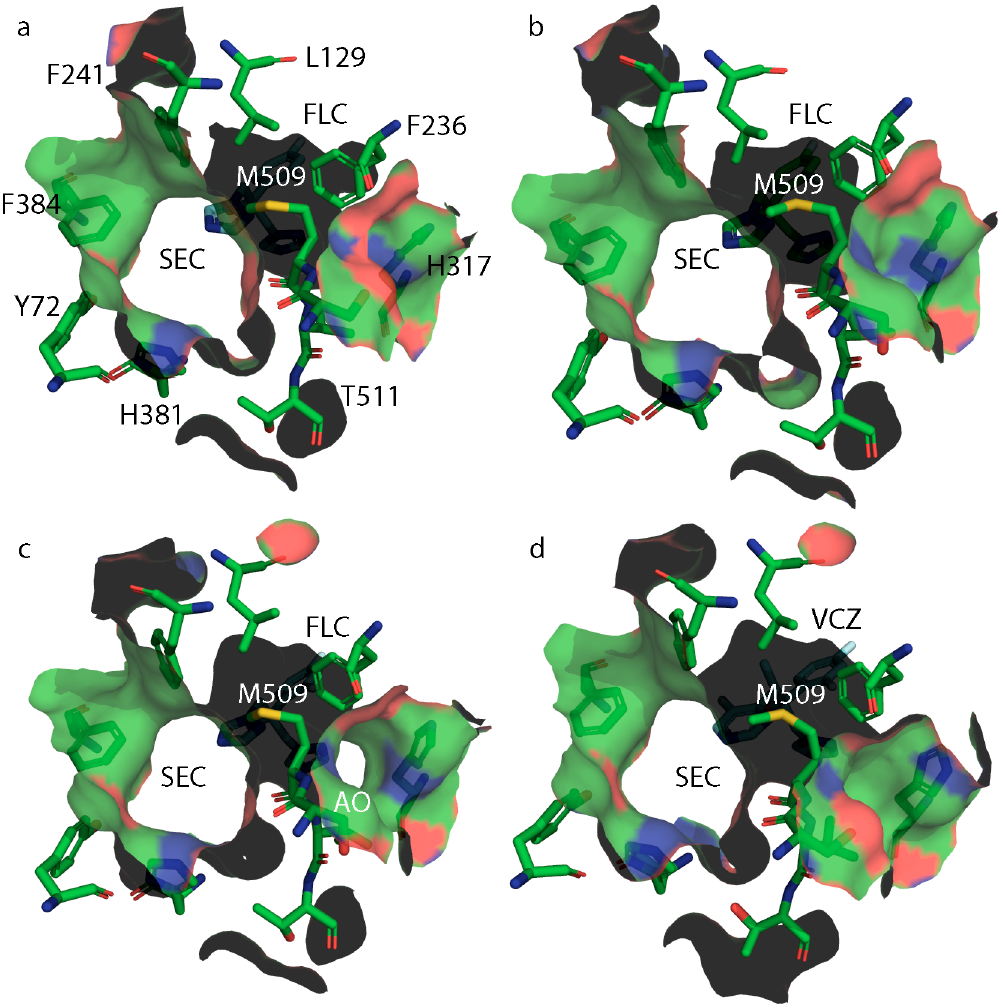
Figure 8. Surface structures at the neck of the substrate entry channel in ScLDM6 × His and its mutants in complex with short-tailed azoles. ( a ) ScLDM6 × His (WT) and with FLC (PDB ID: 4WMZ); ( b ) ScLDM6 × His Y140H with FLC (PDB ID: 4ZE3); ( c ) ScLDM6 × His Y140F with FLC (PDB ID: 4ZDZ); and ( d ) ScLDM6 × His Y140F with VCZ (PDB: 4ZE0). For protein: carbon in green, oxygen in red, nitrogen in blue, sulfur in mustard. For FLC and VCZ: carbon in purple. The surface reflects the color of adjacent protein atoms. SEC, substrate entrance channel. AO, accessory opening.